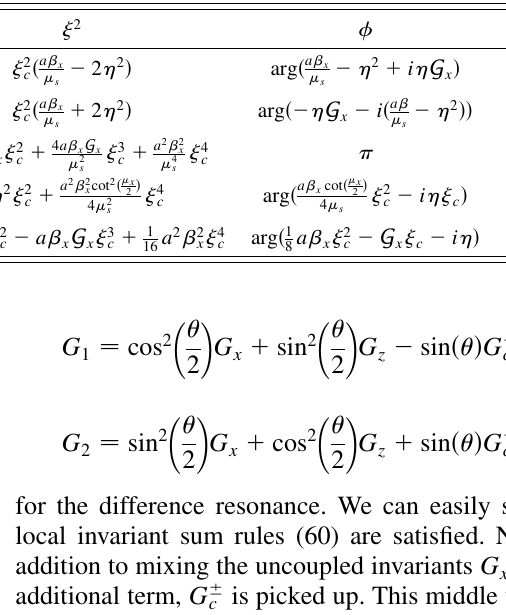
TABLE III. Resonances for crab cavity.